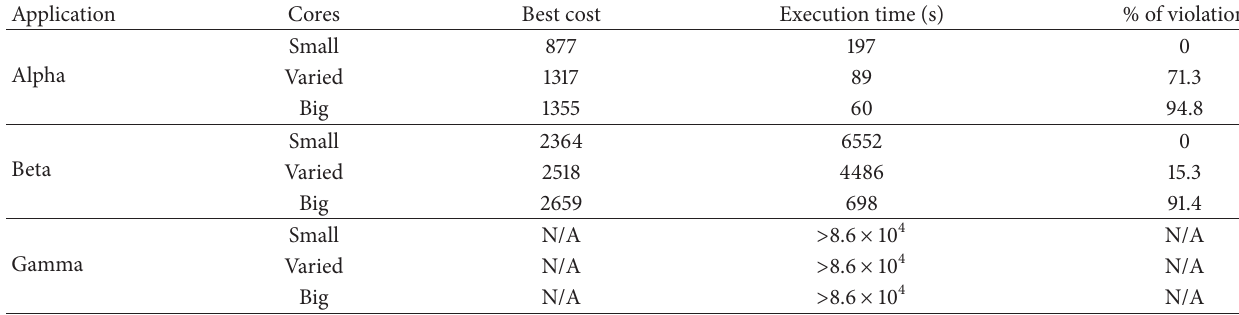
Table 2: Results of the semiexhaustive